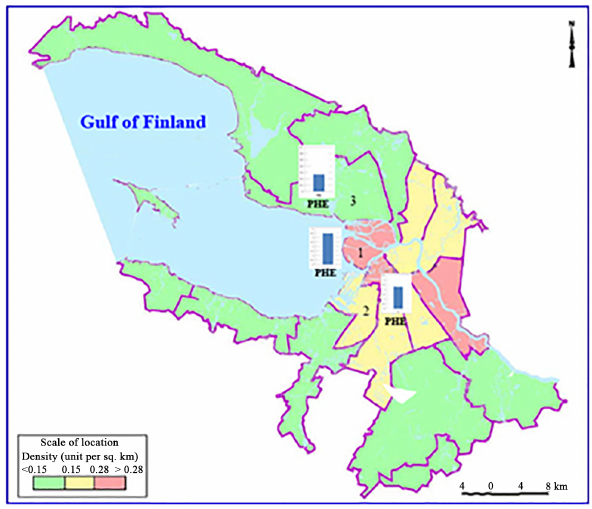
Figure 4. Scale of potential sources of contamination with petroleum products (units per square kilometre) with PHE distri- bution